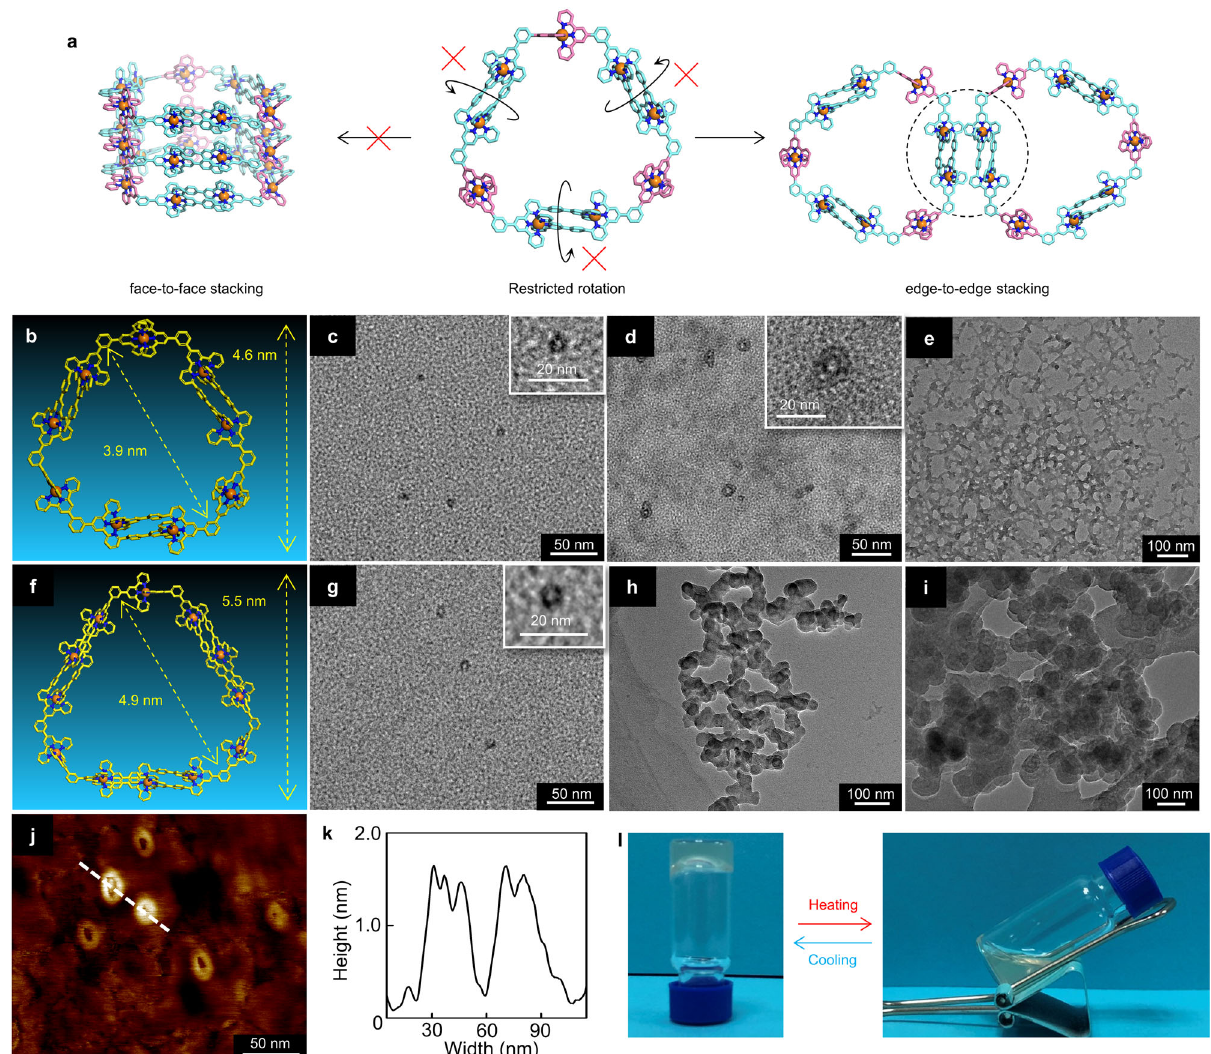
Fig. 6 Characterization of the hierarchical self-assembly of Zn 9 (LA) 6 and Zn 12 (LB) 6 . a Schematic diagram of edge-to-edge stacking by Zn 9 (LA) 6 . b The energy-minimized structure of Zn 9 (LA) 6 from molecular modeling. c TEM images of individual Zn 9 (LA) 6 at a concentration of 10 − 6 M in CH 3 CN (scale bar, 50 and 20 nm for zoom-in image). d TEM images of the assembled cyclic nanostructures of Zn 9 (LA) 6 at a concentration of 10 − 5 M in CH 3 CN (scale bar, 50 and 20 nm for zoom-in image). e TEM images of the 3D network structure formed by assembled cyclic nanostructures of Zn 9 (LA) 6 at a concentration of 10 − 4 M in CH 3 CN (scale bar, 100 nm). f The energy-minimized structure of Zn 12 (LB) 6 from molecular modeling. g TEM images of individual Zn 12 (LB) 6 at a concentration of 10 − 6 M in CH 3 CN (scale bar, 50 and 20 nm for zoom-in image). h TEM images of the assembled cyclic nanostructures of Zn 12 (LB) 6 at a concentration of 10 − 5 M in CH 3 CN (scale bar, 100 nm). i TEM images of the 3D network structure formed by assembled cyclic nanostructures of Zn 12 (LB) 6 at a concentration of 10 − 4 M in CH 3 CN (scale bar, 100 nm). j AFM images of the hierarchically assembled cyclic nanostructures by Zn 9 (LA) 6 (scale bar, 50 nm). k Cross-section of the cyclic nanostructure shown in image j . l Photograph of Zn 12 (LB) 6 gel formation at a concentration of 25 mg/mL in CH 3